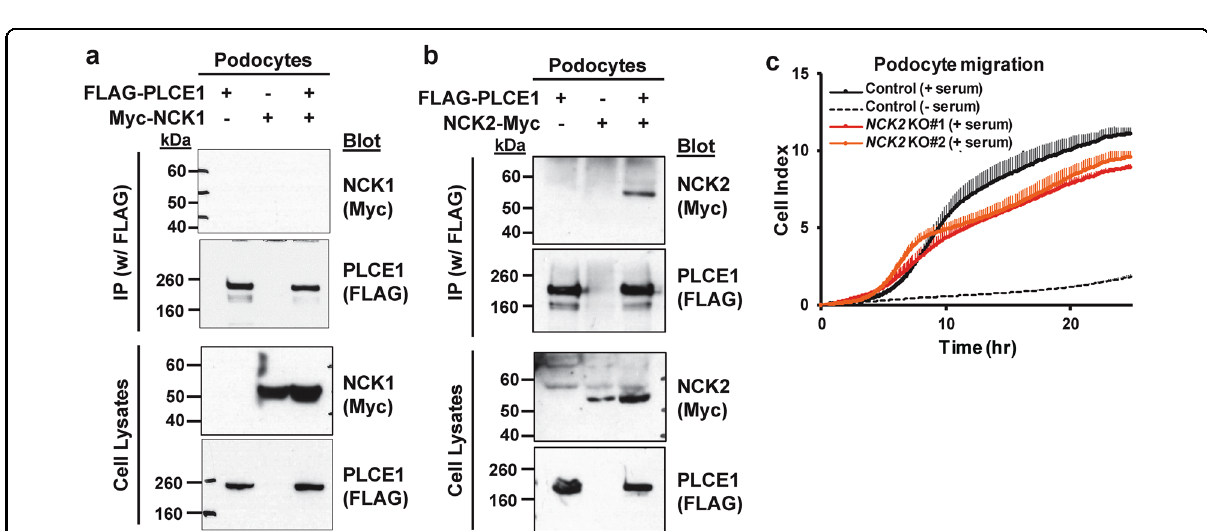
Fig. 5 NCK2 interacts with PLCE1 and affects the migration in podocytes. a , b Interaction of PLCE1 and NCKs. The plasmids containing FLAG- tagged PLCE1 and Myc-tagged NCKs were transfected into podocytes, and cell lysates were immunoprecipitated using anti-FLAG agarose beads. Notably, PLCE1 interacted with NCK2 ( b ) but not with NCK1 ( a ). The immunoblots are representative of more than three experiments. IP, immunoprecipitation. c The effect of NCK2 knockout (KO) on podocyte migration. NCK2-depleted podocytes exhibited decreased migration (red and orange lines) compared with that of the control podocytes (solid black line). Error bars are shown in only one direction for clarity and indicate standard deviations for more than three independent experiments.